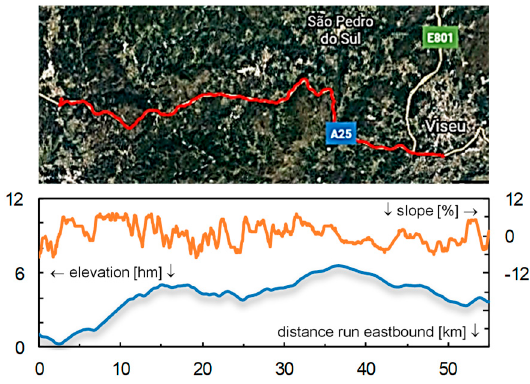
Figure 6. Horizontal and vertical alignments of the Portuguese controlled access highway A25.